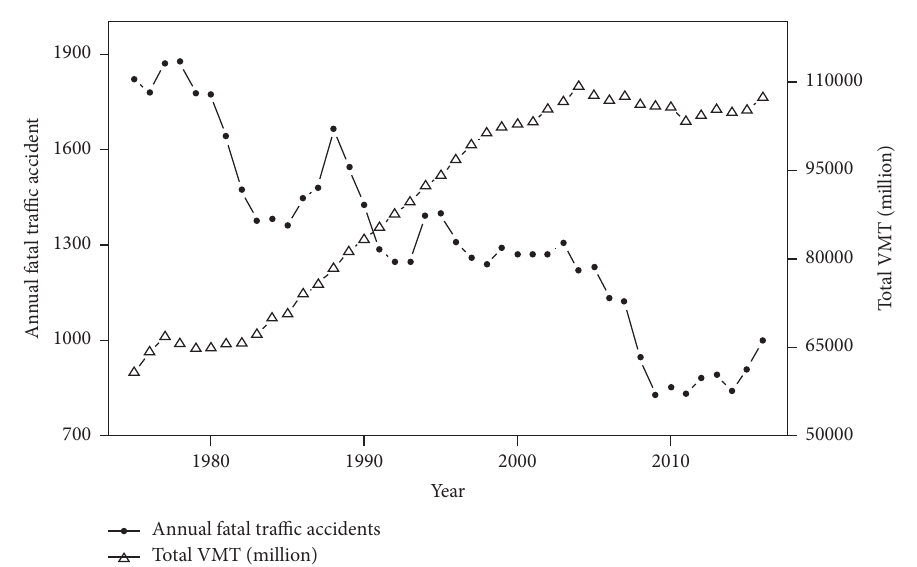
Figure 1: Annual fatal traffic accidents and VMT in Illinois.